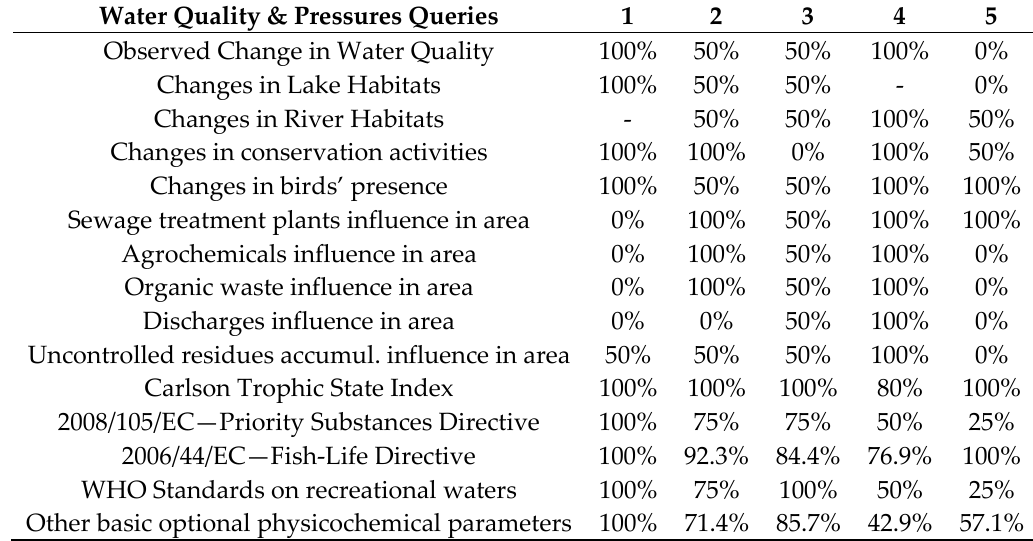
Table 2. Percentages of Gap Analysis of the five P Α s regarding the Water Quality and Pressures. 1: L’ Albufera, 2: Krka, 3: Mincio, 4: Una, 5: